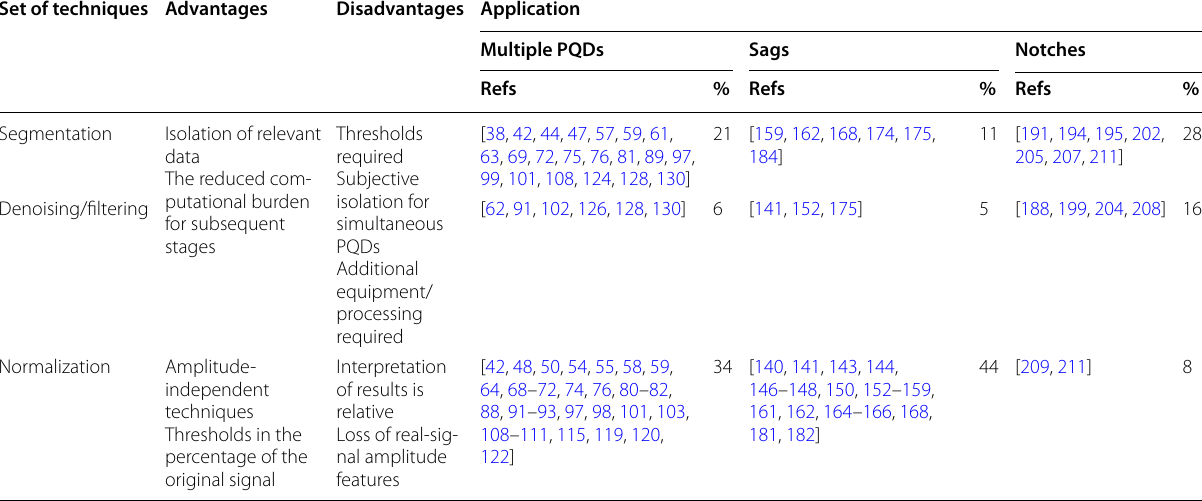
Table 7 Summary of data preprocessing techniques Set of techniques Advantages